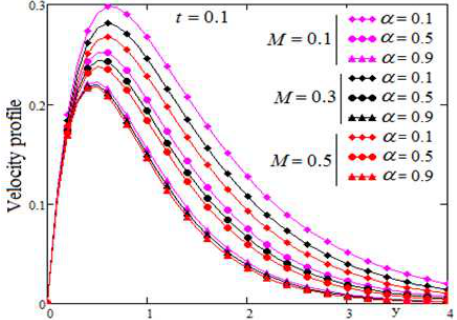
Figure 3. Profile of dimensionless velocity versus y for α variation with Pr = 0 . 7 , S = 5 , Sc = 0 . 8 , λ = 4 , Gr = 3 , Gm = 0 . 9 , and different values of M for small time.